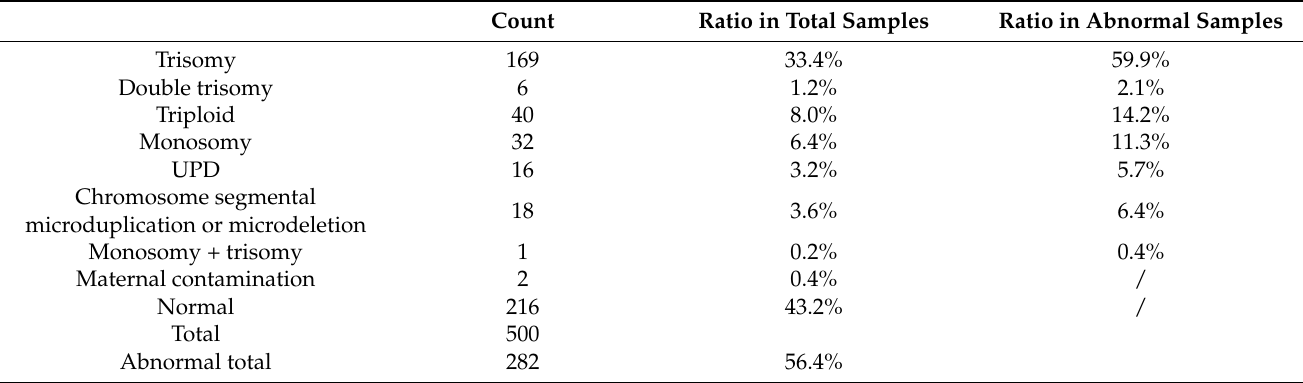
Table 1. Summary of CNV test